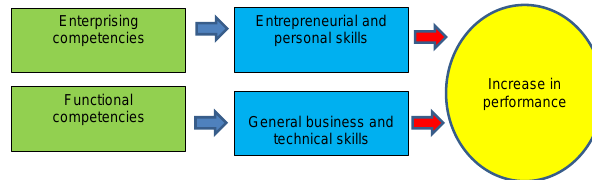
Table 3: List of functional and enterprising competencies required by